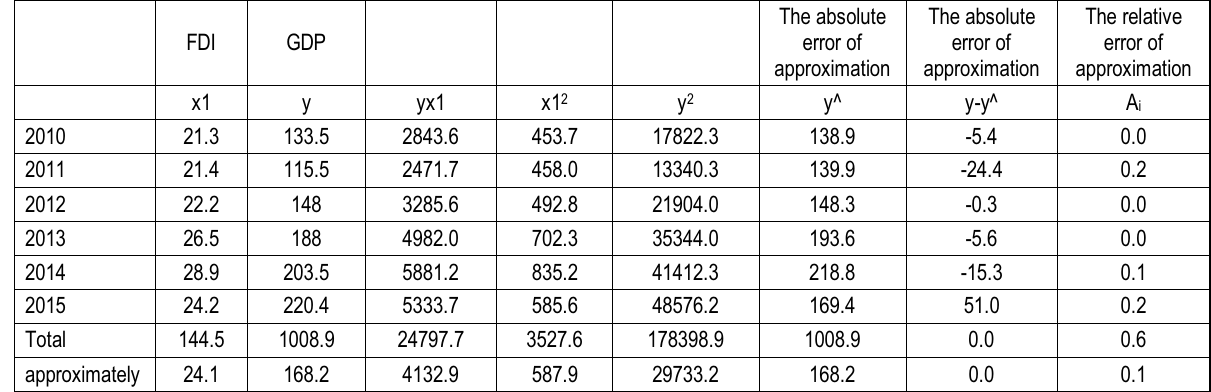
Table 2. Initial data for the regression analysis of